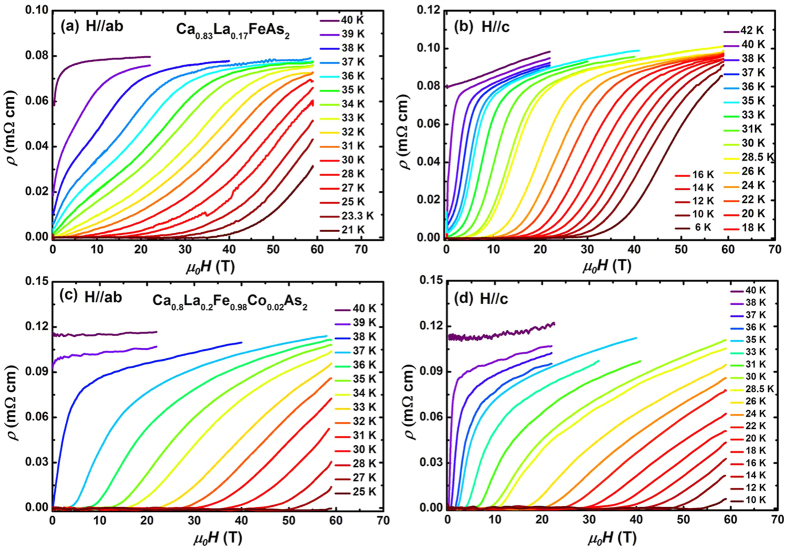
Magnetic field dependence of in-plane resistivity ρ(H) of Ca0.83La0.17FeAs2 for (a) H//ab and (b) H//c, and of Ca0.8La0.2Fe0.98Co0.02As2 for (c) H//ab and (d) H//c measured at fixed temperatures in pulsed fields up to 60 T.